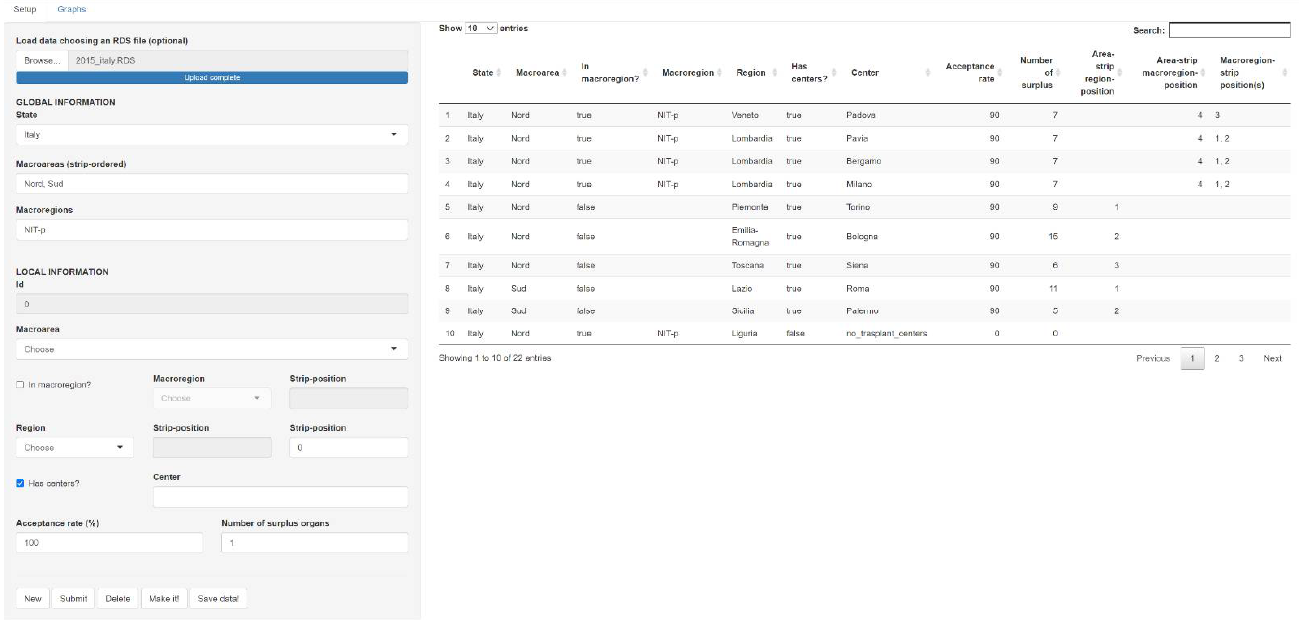
Figure 2. Web interface of the Clumpr app powered by the Shiny R package. The fields to be filled in are about the characteristics of interest defined in the protocol for the allocation of the surplus organs. The example shown in the screenshot reports the data inserted for the center in Padova with an acceptance rate of 90% and with 7 organs that were considered exceeding. The right side shows the other examples used for the probability graphs.